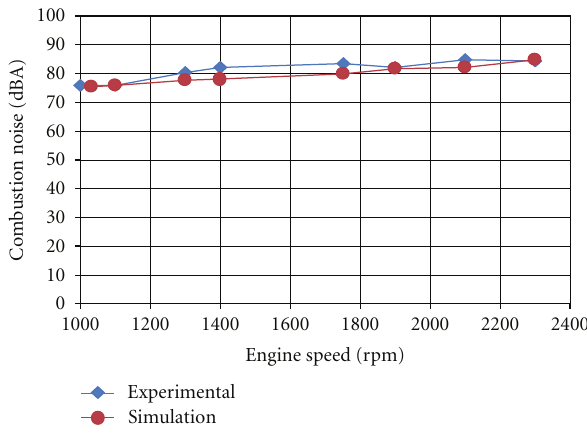
Figure 8: Comparison of experimental and simulated values of normalized fuel flow.